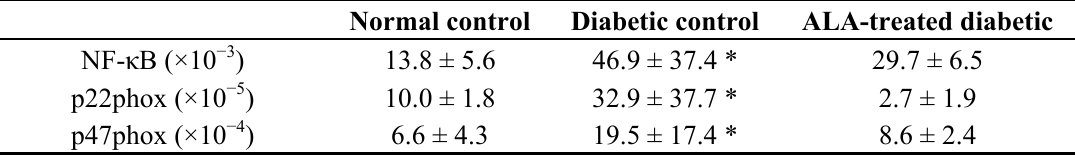
Table 3. The mRNA expression of NF- κ B and NADPH oxidase subunit.